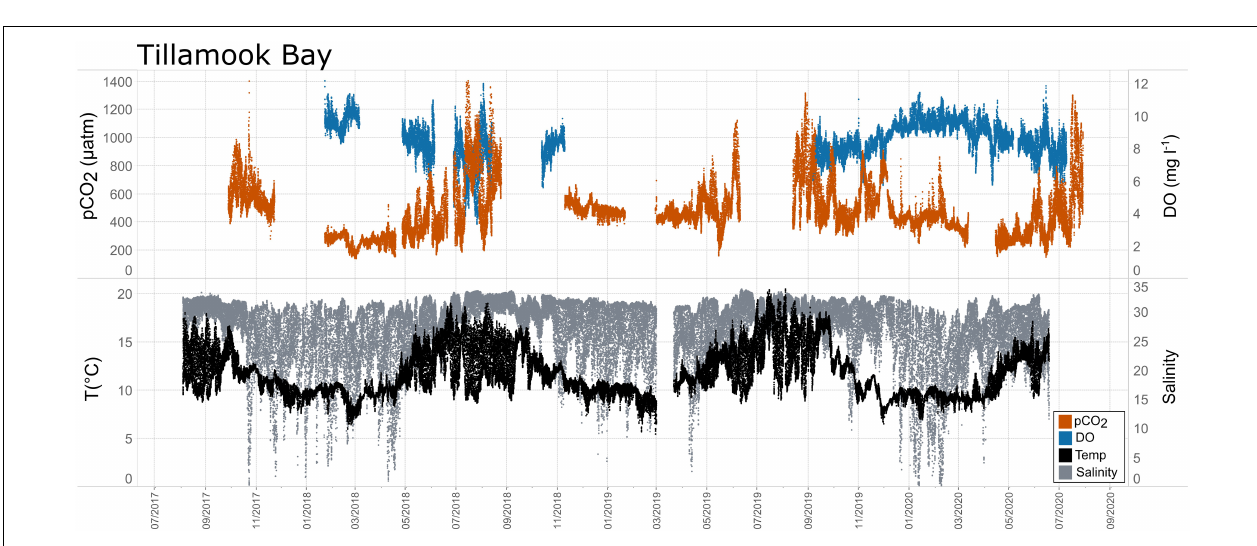
FIGURE 11 | Time series plots of partial pressure of carbon dioxide ( p CO 2 ), dissolved oxygen (DO), temperature, and salinity in Tillamook Bay (July 2017 – July